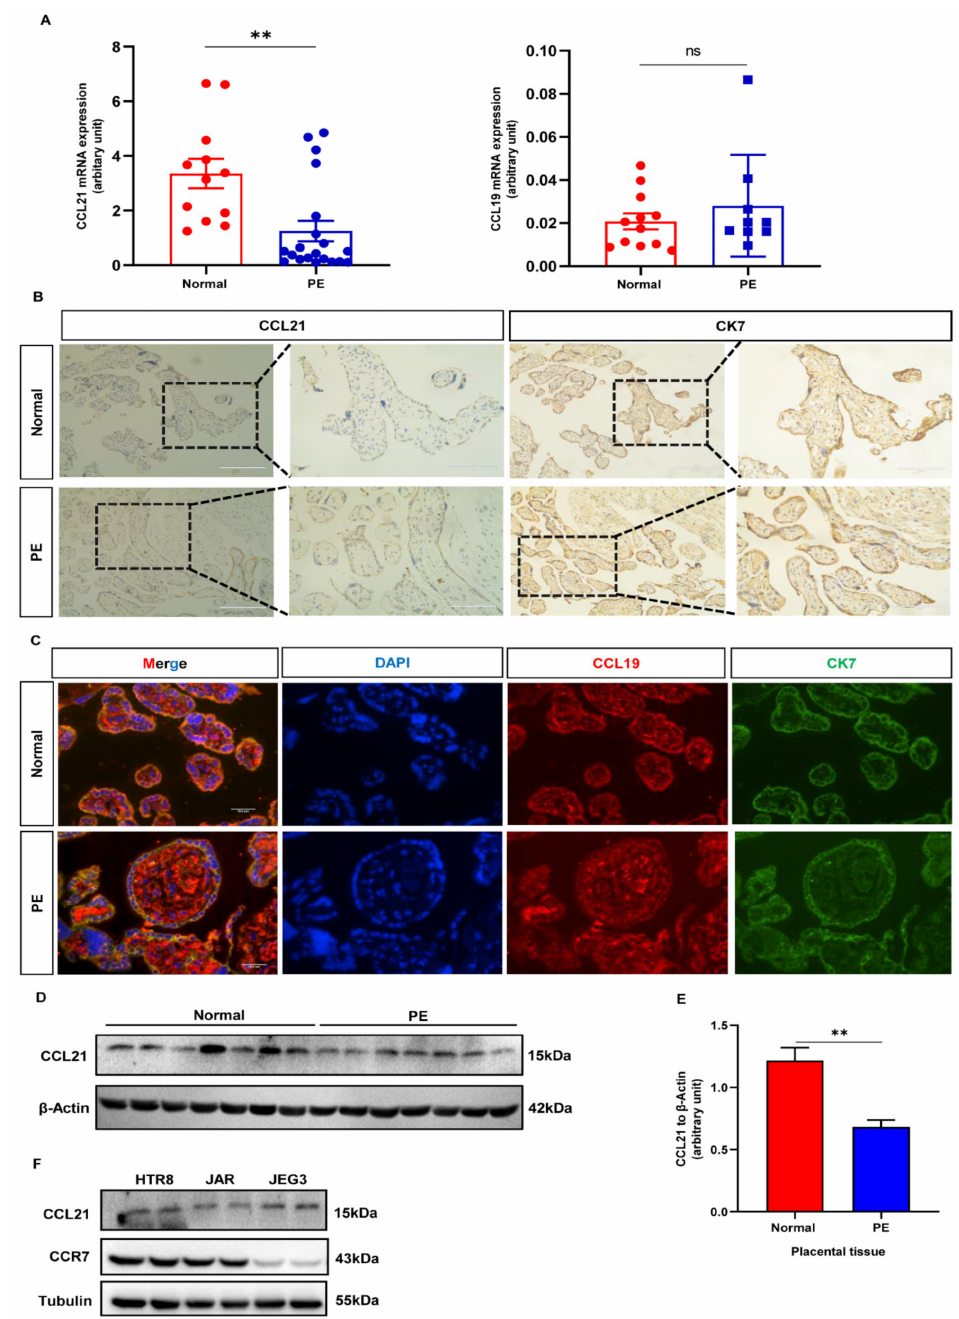
Figure 3. CCL21 and CCL19 expression in human placental tissues from the PE group and the control group. ( A ) Expression of CCL21 and CCL19 mRNA in the PE group ( n = 20; n = 9) and the control group ( n = 12) by qRT-PCR. ( B ) Immunohistochemistry staining of CCL21 in human placental tissues in the PE group and normal group. Scale bar-100 µ m. ( C ) Double-stained immunofluorescence of CCL19 in the human placental tissues in the PE group and normal group. Here, CK7 is indicated by green signals, while CCL19 is indicated by red signals. Scale bar-10 µ m. ( D ) Western blotting analysis of CCL21 in normal ( n = 7) and PE ( n = 7) placental tissues (Supplementary File S1). ( E ) Statistical analysis of protein densitometry quantification in Figure 3D. ( F ) Western blotting analysis of CCL21 and CCR7 in HTR-8/SVneo, JAR, and JEG3 cells (Supplementary File S1); ** p < 0.01; ns,